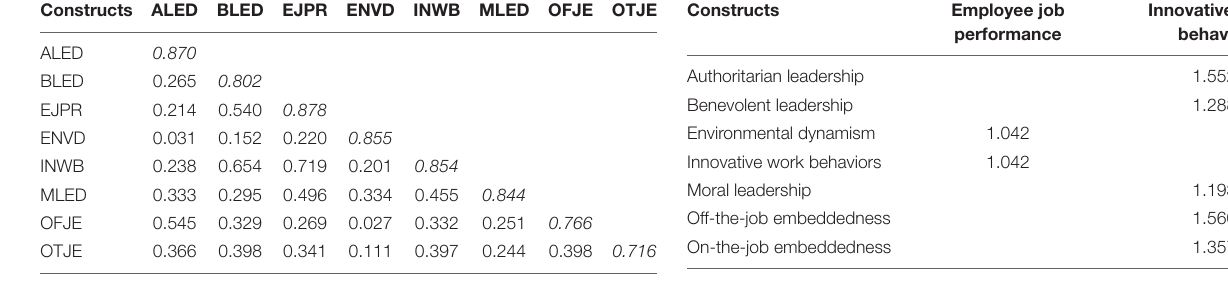
TABLE 3 | Discriminant validity with the heterotrait-monotrait ratio (HTMT) method. Constructs ALED BLED EJPR ENVD INWB MLED OFJE OTJE